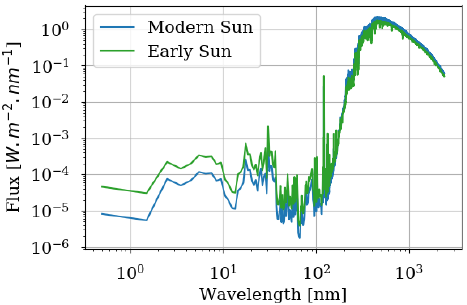
Figure 1. Stellar flux received by modern Earth computed for 0.0Ga and 1.0AU as well as stellar flux received by early Earth computed for 2.7Ga and 1.0AU from Claire et al.